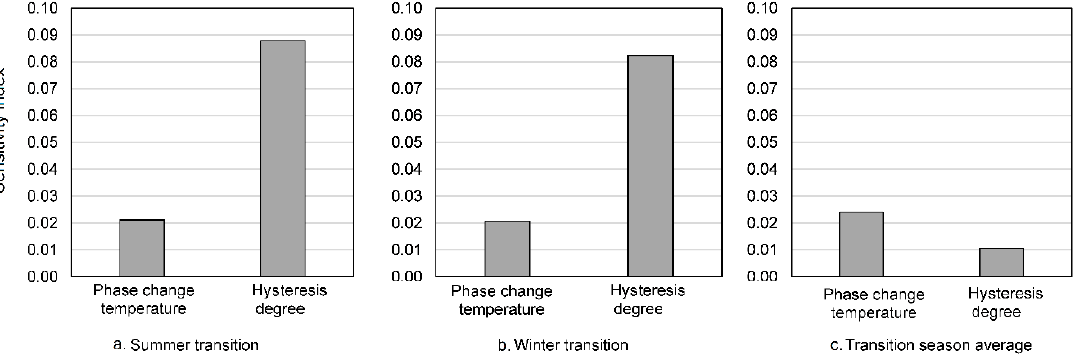
Figure 16. The sensitivity indexes of phase change temperature and hysteresis degree on the PPD: ( a ) the summer transition season; ( b ) the winter transition season; ( c ) the transition season average.